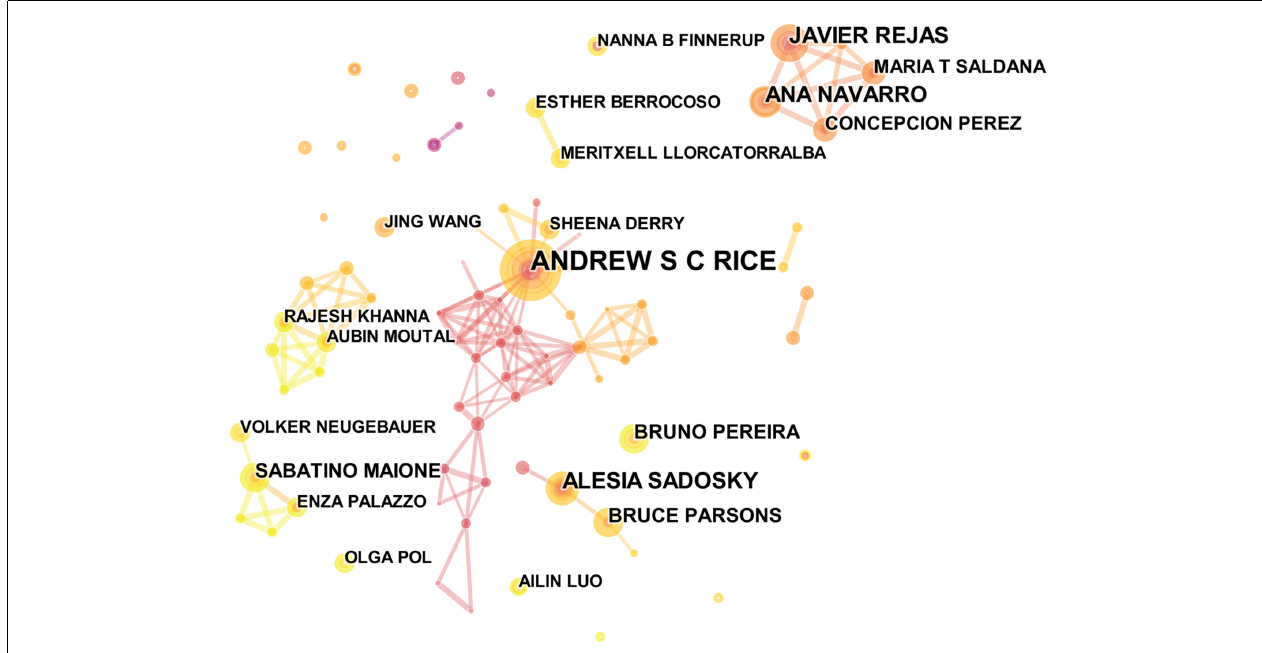
FIGURE 9 | The analysis of authors. Network map of active authors contributed to NP associated with anxiety or depression